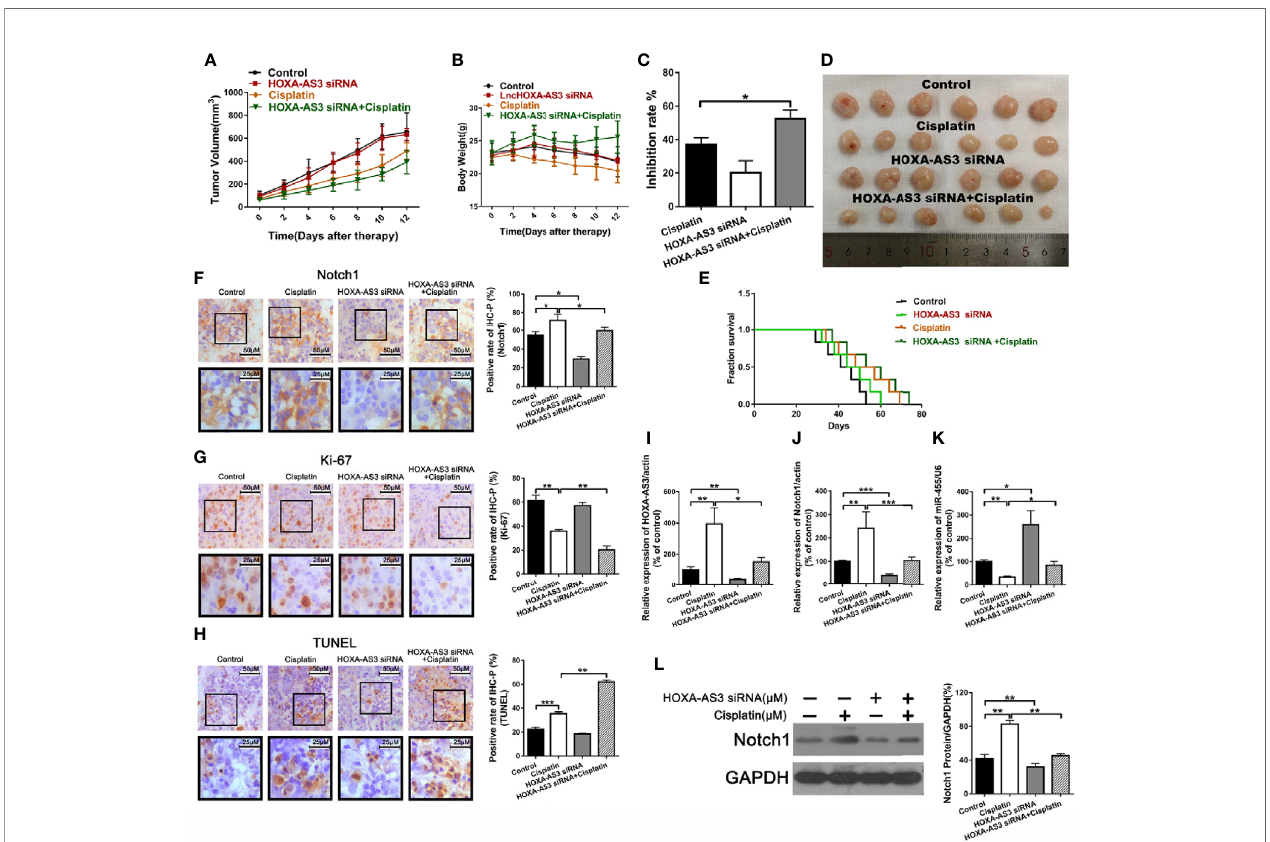
FIGURE 7 | Suppression of HOXA-AS3 enhances the cisplatin sensitivity of bladder cancer cells in vivo . (A) Volume of tumor xenografts. (B) Body weights of mice measured on day 0 – 12. (C) Tumor inhibition rate. (D) Tumors isolated from nude mice. (E) Kaplan – Meier curves of mice in the saline groups. (F – H) Notch1 and Ki-67 staining in the different treatment groups (left) and rate of positive staining (right). *P < 0.05, **P < 0.01. (G) TUNEL assay of the level of apoptosis in the different treatment groups. **P < 0.01, ***P < 0.001. (I – L) HOXA-AS3, Notch1, and miR-455-5p expression levels in tumor tissues using qRT-PCR. *P < 0.05, **P < 0.01, ***P < 0.001. (K) Western blot analysis of HOXA-AS3 and Notch1 expression in tumor tissues. **P <